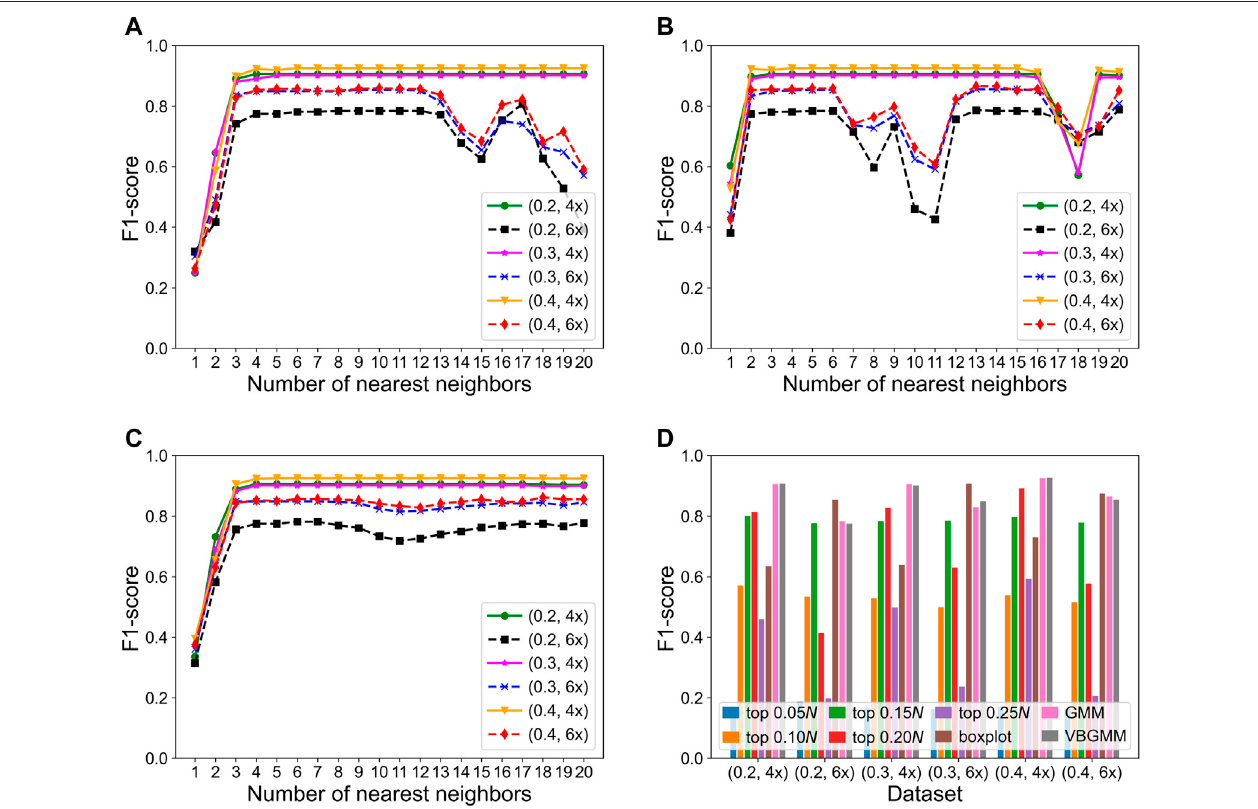
FIGURE 3 | F1-score on the simulated datasets. (A-C) Variation of different outlier score schemes generated by the KNN with the number of nearest neighbors, where 1 – 20 denote 0.05 , 0.10 , 0.15 N , ... , 0.95 N , and 1.00 N , respectively. The different outlier score schemes are the median outlier score scheme (A) , the largest outlierscorescheme (B) ,andtheaverageoutlierscorescheme (C) . (D) Resultwithdifferentthresholdselectionstrategiesundertheframeworkofourmethod,wherethe ‘ top n ’ denotesasimplethreshold,and n belongstotheset{0.05 ,0.10,0.15,0.20 ,0.25 N }.Speci fi cally,aftertheoutlierscoresarerankedindescendingorder,the scheme treats the genome segments corresponding to the fi rst n scores as CNVs. Note that 1 – 20 and n are rounded down.